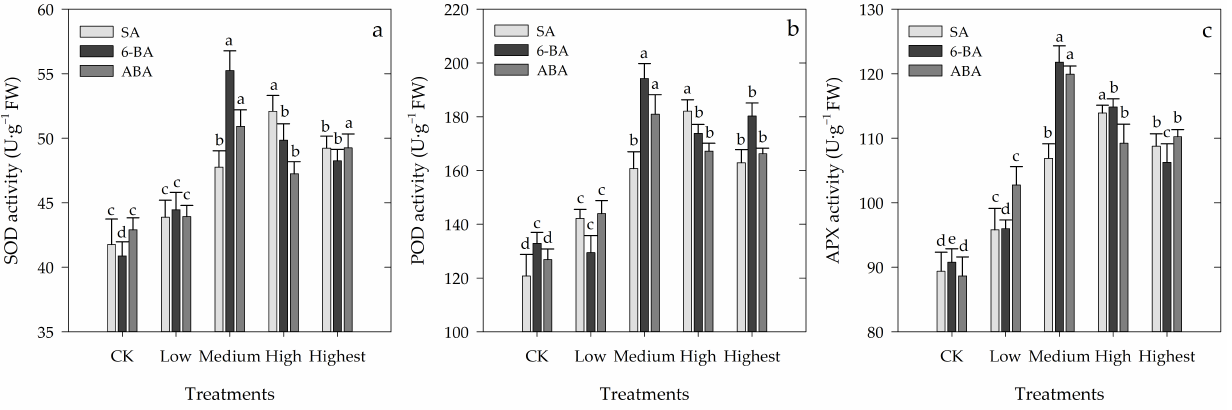
Figure 5. Effects of different concentrations of SA, 6-BA or ABA on activities of the antioxidant en- zymes SOD ( a ), POD ( b ) and APX ( c ) of Rosa hybrida ‘Carolla’. CK: distilled water. Low, 0.5 mmol·L −1 SA, 10 μmol·L −1 6- BA, 37.5 μmol·L −1 ABA; medium: 1.0 mmol·L −1 SA, 20 μmol·L −1 6- BA, 75 μmol·L −1 ABA; high: 1.5 mmol·L −1 SA, 30 μmol·L −1 6- BA, 112.5 μmol·L −1 ABA; highest: 2.0 mmol·L −1 SA, 50 μmol·L −1 6- BA, 187.5 μmol·L −1 ABA; Vertical bars denote standard errors ( n = 10). The values are described as the means ± SD; different letters denote significant differences ( p < 0.05) according to Duncan’s multiple range tests.